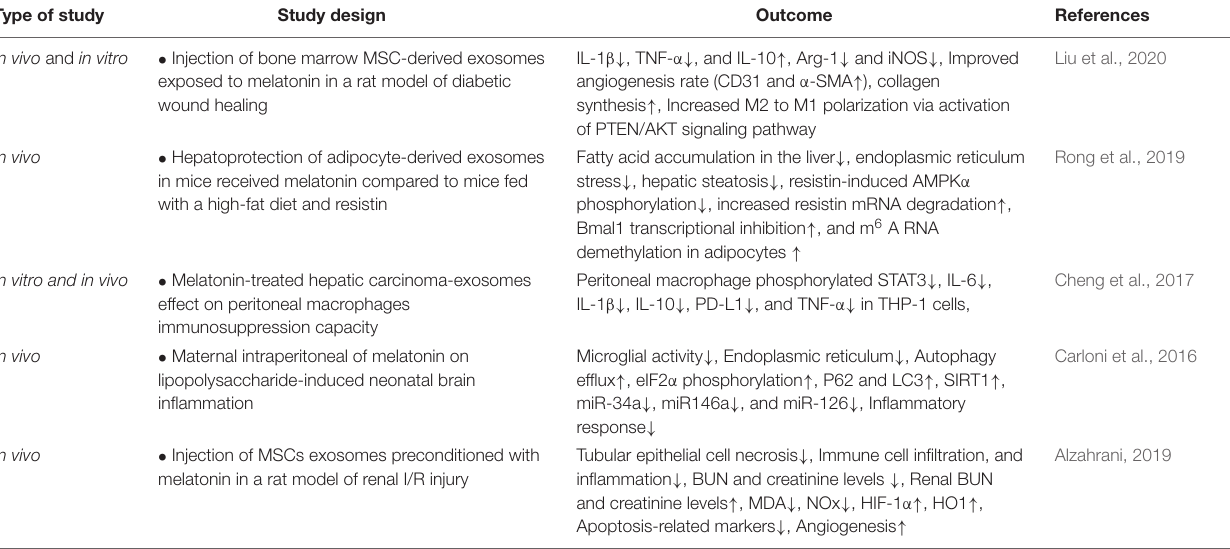
TABLE 1 | Melatonin could alter exosomal